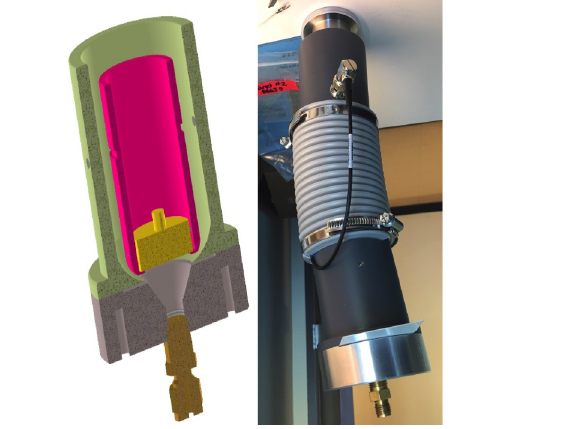
Figure 4. Air Monitoring System. Left panel shows a cutaway of the system, where air from the isotope production chamber enters from the top and flows around the pink cylinder, pulled by a pump attached to the gold nozzle. The yellow cylinder indi- cates the presence of a silicon PIPS detector which detects alpha particles emitted from isotopes caught by the fiberglass filter (not depicted here). Right panel shows a photograph of the actual de- vice. The white card is the fiberglass filter.